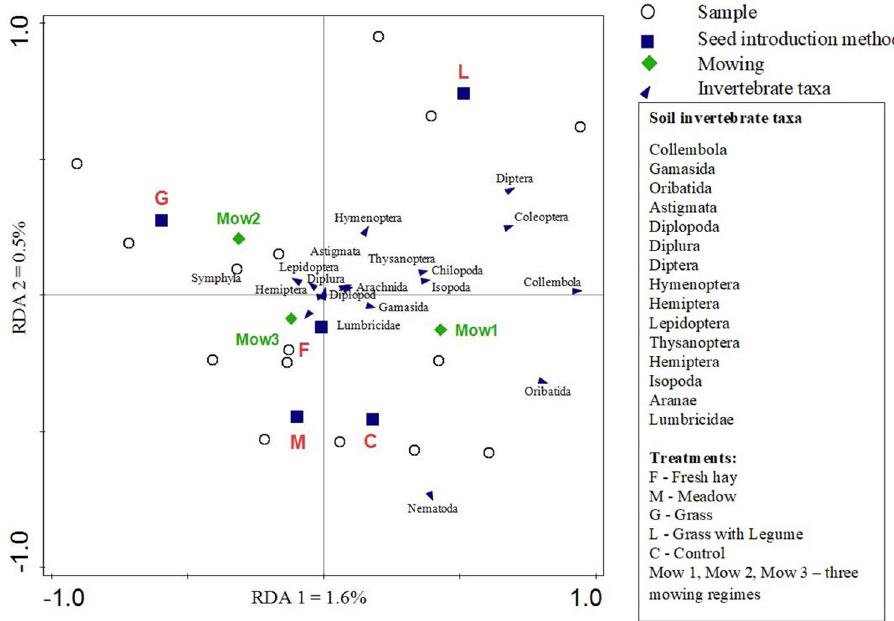
Figure 4. The redundancy analysis biplot of soil invertebrate community in association with mowing, seed introduction methods, and